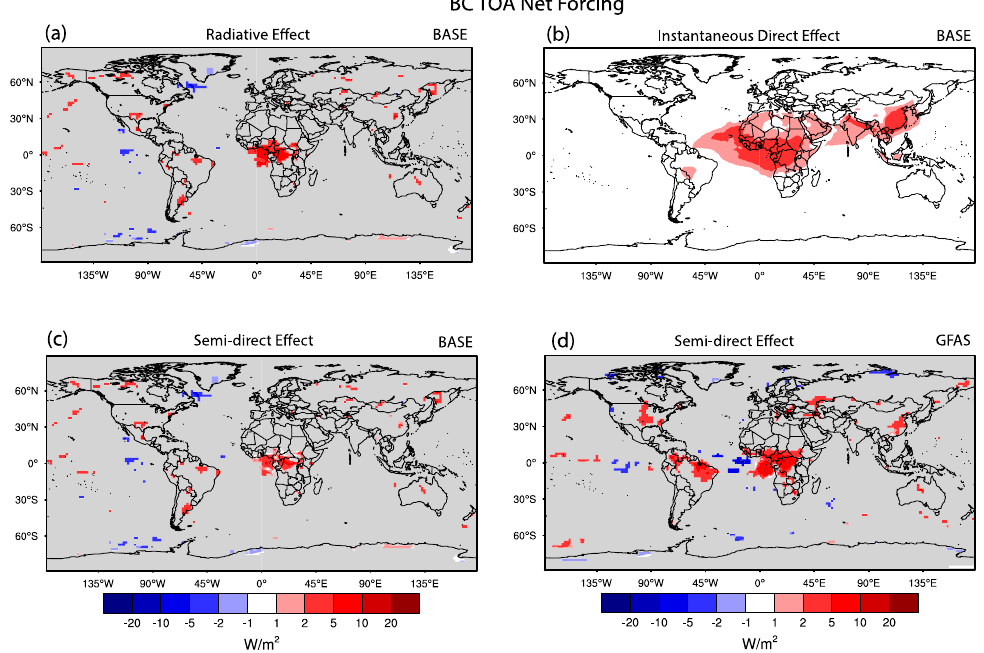
Figure 4. ( a ) Direct radiative effect (DRE) of BC aerosol calculated from TOA radiative fluxes as difference of experiments BASE-noBC; ( b ) instantaneous radiative effect (IDR) calculated as ( a ) but excluding changes in cloud cover by BC forcing via double call to the radiation scheme in the model, and ( c ) semi-direct effect (SDE) at the top of atmosphere in Wm − 2 calculated as DRE-IDR. ( d ): as ( c ), for the GFAS simulation. Grey areas indicate regions where the results are not statistically significant at 95% level. Table 2. Results of the global annual average top-of-atmosphere direct radiative effect (DRE), instantaneous direct radiative effect (IDR) and semi-direct radiative effect (SDE) computed from pairs of model simulations (see Table 1). Additionally, results for solar (SW) and thermal (LW) parts of the spectrum are provided, as well as total cloud cover changes. All model grid cells are considered for the averages.